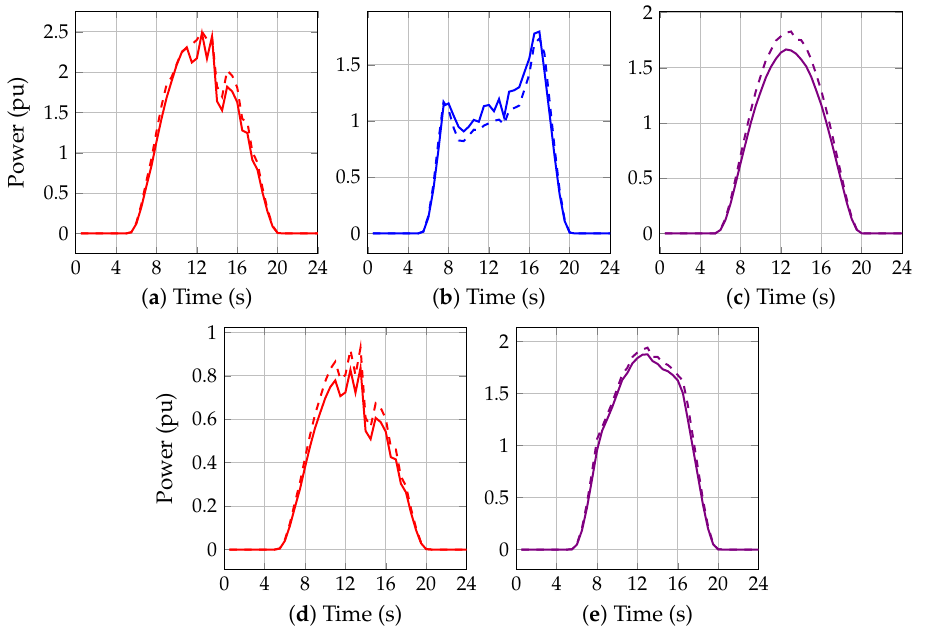
Figure 6. The dispatched PV power for the robust model (solid line) and the deterministic model (dashed line): ( a ) PV generator connected to positive pole at node 3, ( b ) PV generator connected to positive pole at node 11, ( c ) PV generator connected to positive pole at node 17, ( d ) PV generator connected to negative pole at node 3, and ( e ) PV generator connected to negative pole at node